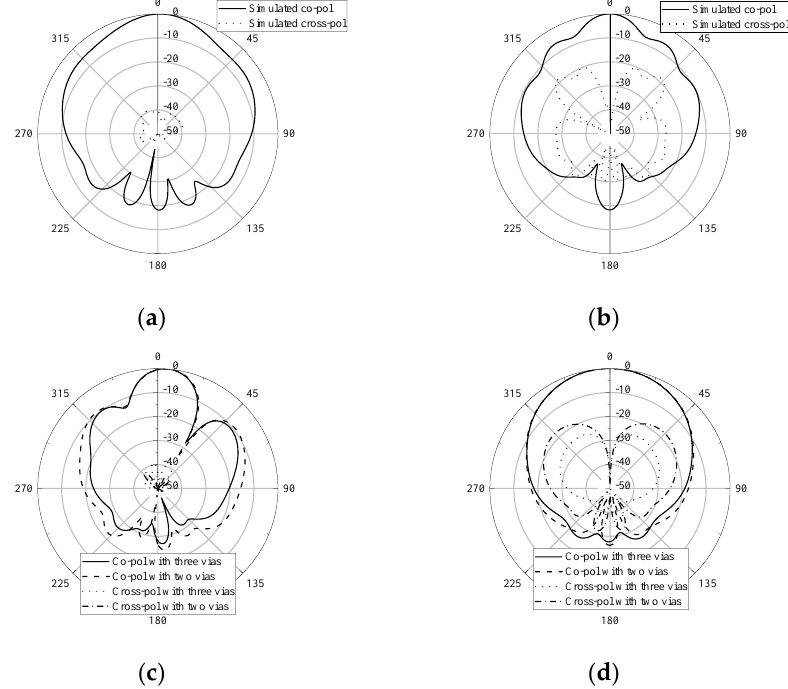
Figure 3. Simulated radiations for the 1-D 3 × 1 interconnected ME dipole array along the x-direction ( a ) in the E plane at 28 GHz and ( b ) in the H plane at 28 GHz, and for the 1-D 1 × 3 interconnected ME dipole array along the y-direction ( c ) in the E plane at 28 GHz and ( d ) in the H plane at 28 GHz.